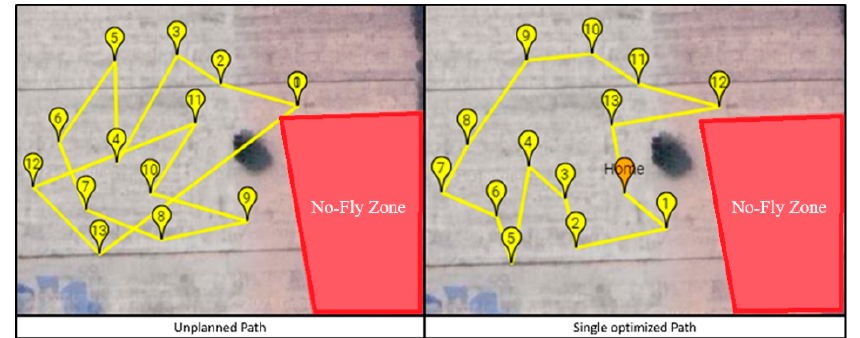
Figure 6. Single-route solution.